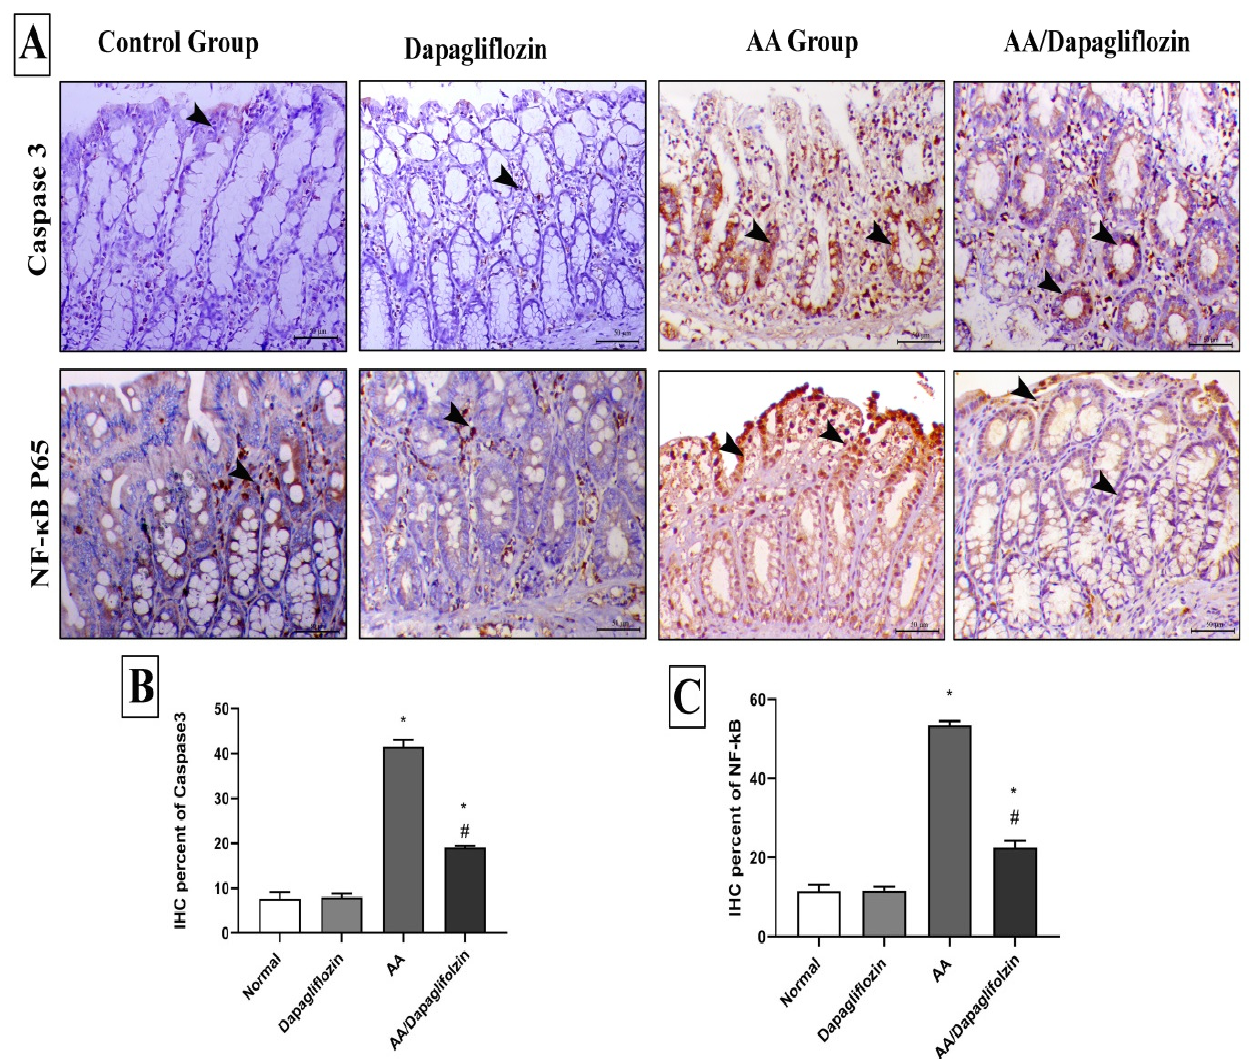
Figure 7. Immunohistochemical analysis of colonic expression of Caspase-3 and NF- κ B P65 antibodies. ( A ) The first panel indicates the immunostaining of Caspase-3 within the colonic mucosa and the second panel indicates the expression of NF- κ B P65 within the mucosa of the different treated groups (arrowheads indicate the positive expression). ( B ) Quantitative scoring of Caspase-3 represented with the mean of the percentage of positive expression of the different groups. ( C ) Quantitative scoring of NF- κ B P65 represented with the mean of the percentage of positive expression of the different groups. Superscript letters indicate the level of statistical significance that was performed using one-way ANOVA followed by the Tukey–Kramer multiple comparisons test (* p < 0.05, DAPA compared to the normal control group; # p < 0.05, DAPA compared to the UC control